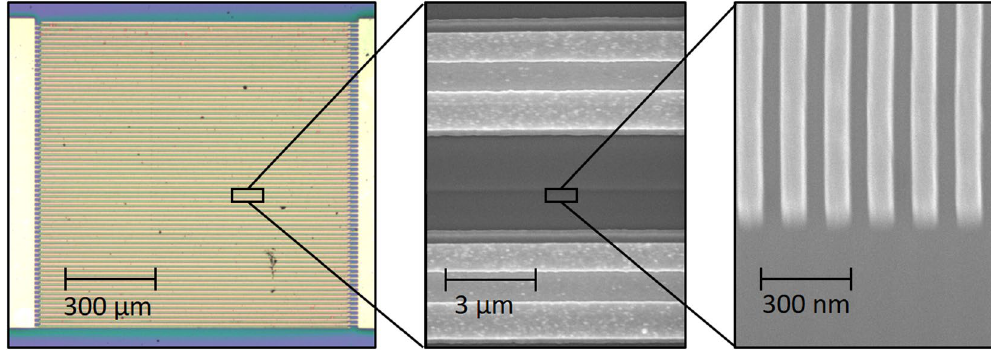
Figure 3. Optical microscopy image of the terahertz source prototype and scanning electron microscopy images of the bias lines, shadow metals and plasmonic nanoantennas.